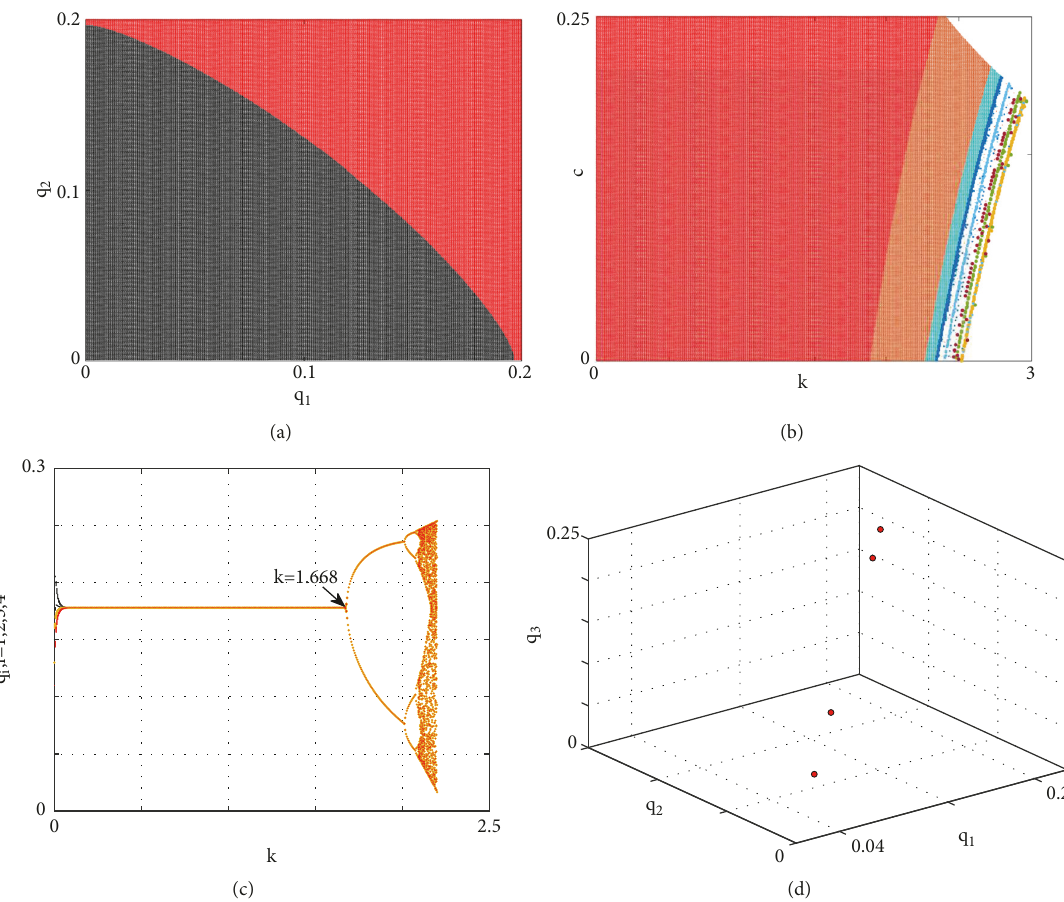
Figure 2: (a) The basin of attraction of the period 2-cycle at (𝑎, 𝑐, 𝑘, 𝛼, 𝑞 3 ,𝑞 4 ) = (0.7, 0.11, 2.2, 0.5, 0.13, 0.11) . (b) 2D bifurcation in the (𝑘,𝑐) parameter plane at (𝑎, 𝛼,𝑞 , 𝑞 , 𝑞 ,𝑞 ) = (0.7,0.11, 2.2, 0.5, 0.19, 0.15, 0.13, 0.11) . (c) Bifurcation diagram of system (6) with 0,1 0,2 0,3 0,4 respect to 𝑘 at (𝑎,𝑐,𝛼,𝑞 0,1 ,𝑞 0,2 , 𝑞 0,3 ,𝑞 0,4 ) = (1, 0.11, 0.5, 0.19, 0.15, 0.13, 0.11) . (d) Phase portrait of the period 4-cycle of system (6) at (𝑎,𝑐,𝑘,𝛼,𝑞 , 𝑞 ,𝑞 , 𝑞 ) = (0.9,0.11, 2.2, 0.5, 0.19, 0.15, 0.13, 0.11) 0,1 0,2 0,3 4